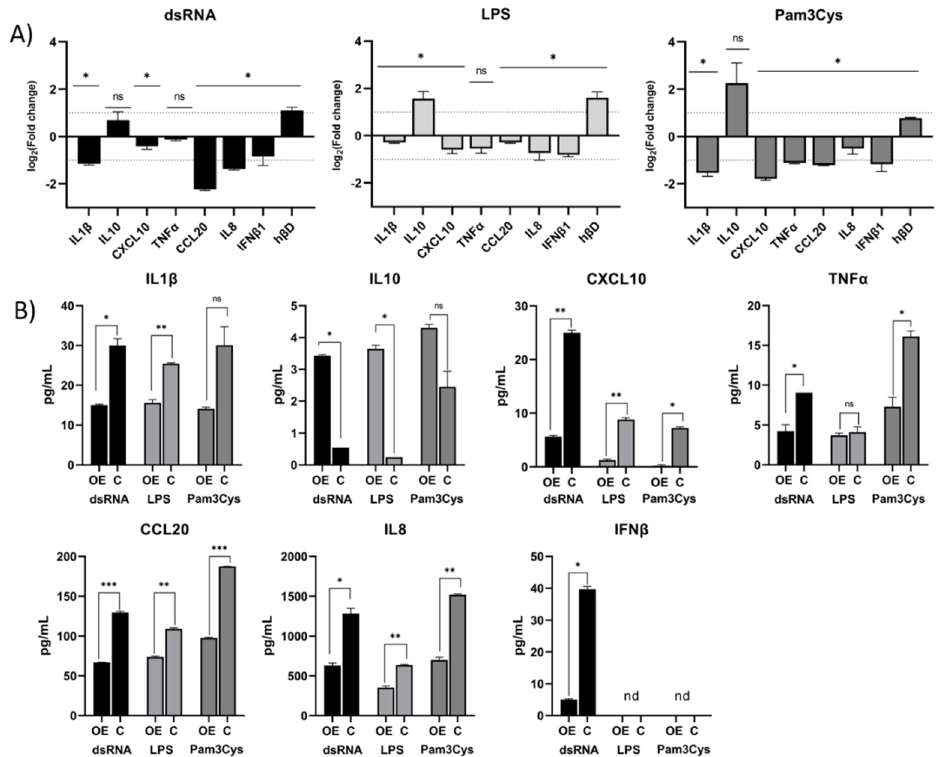
Figure 4. Effect of TLR10 overexpression on inflammatory mediators. ( A ) The panel shows differential expression (log 2 (FC)) of inflammatory mediators in the challenged A549-TLR10 OE compared to controls (challenged A549 cells transfected with empty vectors). Cells were stimulated with dsRNA (10 µg/mL), LPS (50 ng/mL), or Pam3Cys (50 ng/mL) for 4 h. Data are means ± SD of three different experiments performed in triplicates. ( B ) Bar graphs depict the levels of secreted inflammatory mediators as determined by ELISA. Supernatants for IL1 β , CXCL10, TNF α , CCL20, and IL8 were collected 4 h post challenge, while supernatants for IL10 and IFN β were collected 24 h post challenge. Data are means ± SD of three different experiments completed in duplicates, * p < 0.05, ** p < 0.01, *** p < 0.0001; ns = not significant; nd = not detected.